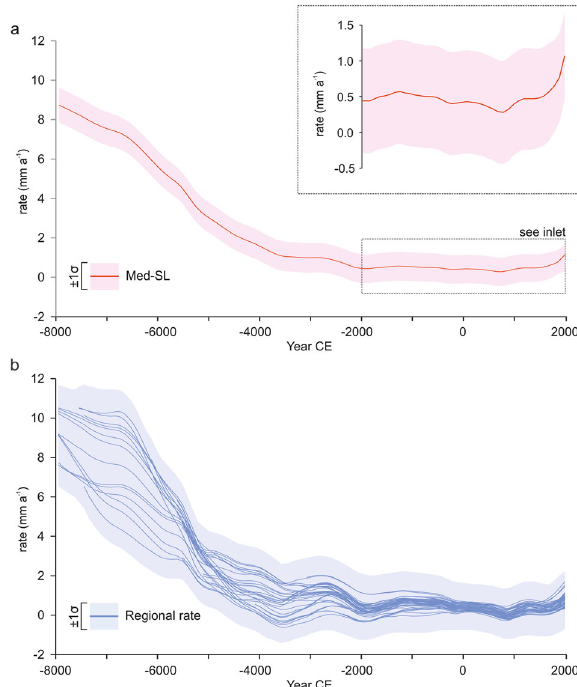
Fig. 2 Rates of relative sea-level change for the central and western Mediterranean region in the last 10,000 years. a Common sea-level signal (Med-SL). The inlet graph shows the Med-SL variation in the last 4000 years. The solid line and shaded envelope denote the model mean and the 1 σ uncertainty (see Supplementary Table 2). b variability of relative sea-level (RSL) change rates in the 48 central and western Mediterranean regions included in the analysis. The solid line and shaded envelope are the model mean and 1 s